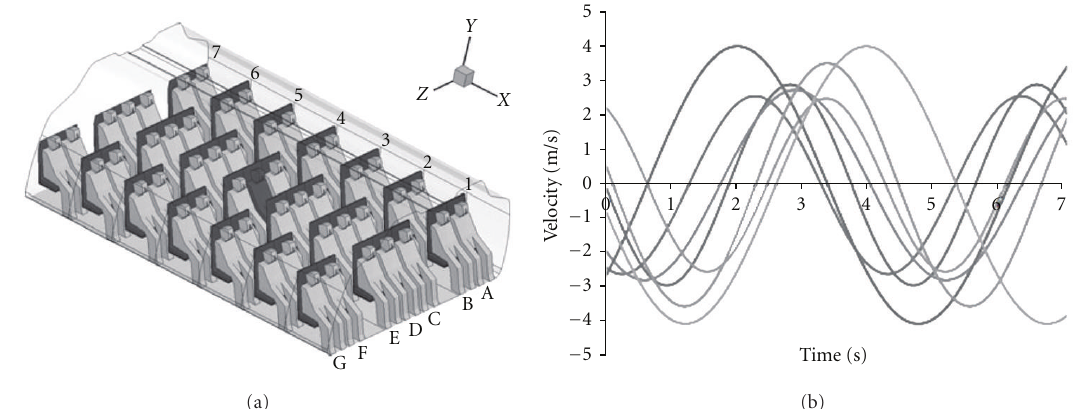
Figure 10: (a) Fully occupied aircraft cabin, with the index passenger in the center. (b) Random breathing curves considered at the nose of passengers